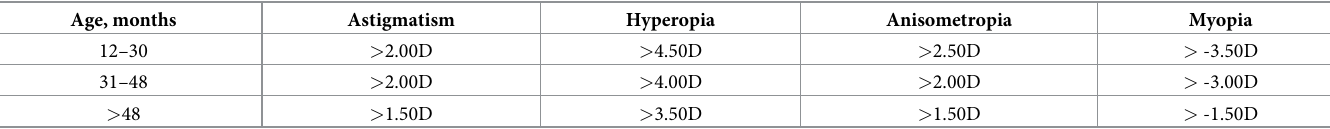
Table 1. AAPOS amblyopia risk factors targeted with automated preschool vision screening